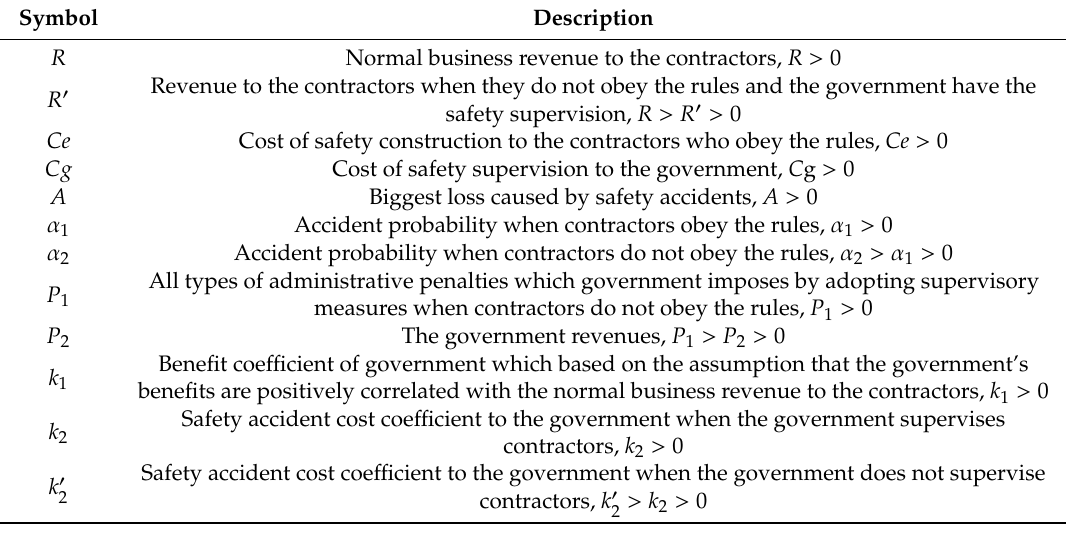
Table 1. Summary of notations.